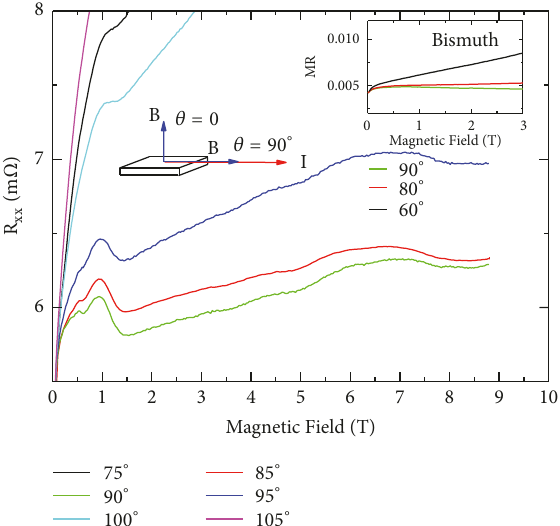
Figure 5: Magnetoresistance measured for different angles between the magnetic field B and the current I , as indicated in the schematic drawing. At 𝜃 = 90 𝑜 B ‖ I . The data are taken at T =2 K. The inset shows the magnetoresistance of a pure Bi single crystal for 3 different angles 𝜃